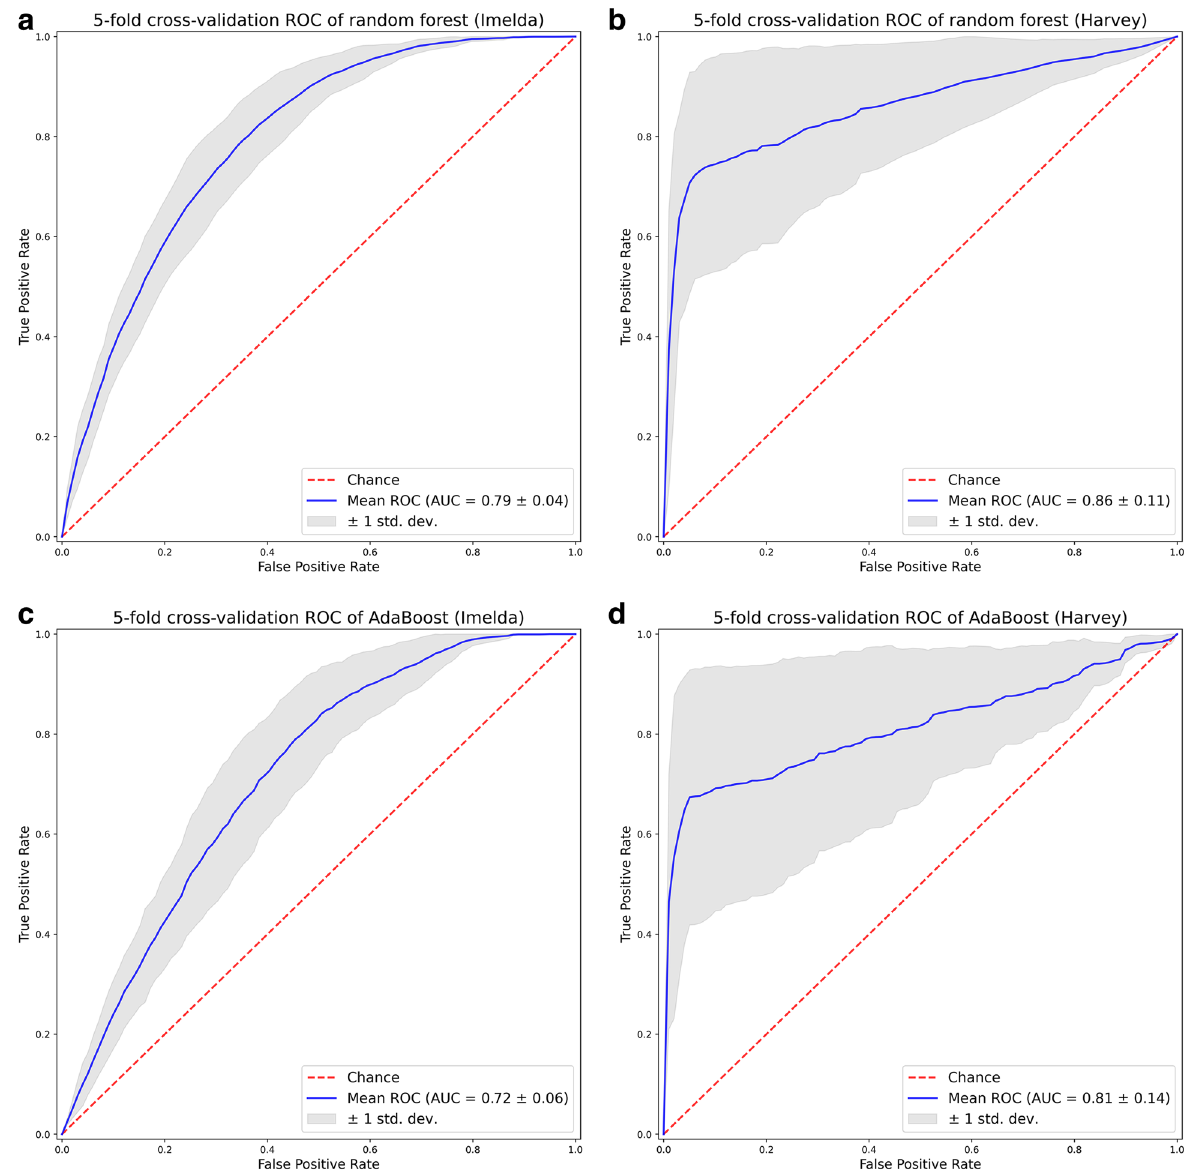
Fig. 4 Part 1: Receiver operating characteristic (ROC) curves for 10‑ iteration fivefold cross‑validation with random forest model for Tropical Storm Imelda ( a ) and Hurricane Harvey ( b ); Part 2: Receiver operating characteristic (ROC) curves for tenfold cross‑validation with AdaBoost model for Tropical Storm Imelda ( c ) and Hurricane Harvey ( d